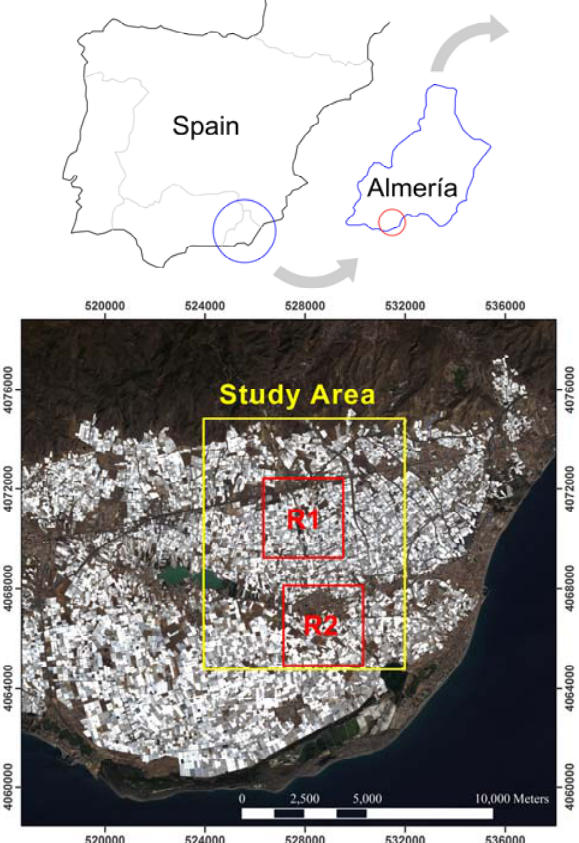
Figure 1. Location of the study area (yellow rectangle) and two subareas (red squares). Coordinate system: ETRS89 UTM